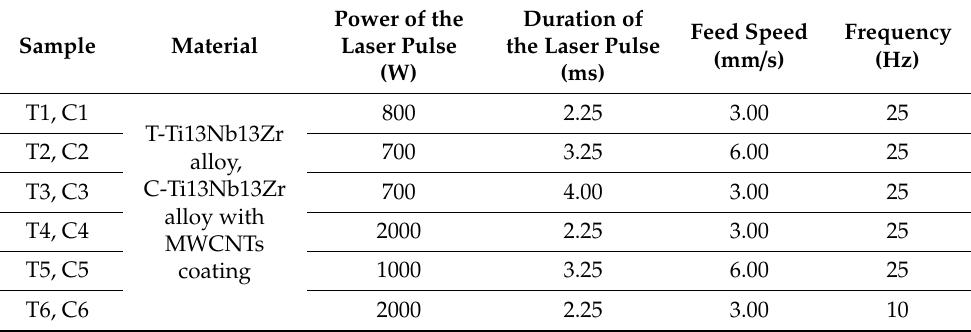
Table 2. Parameters of laser processing of the tested